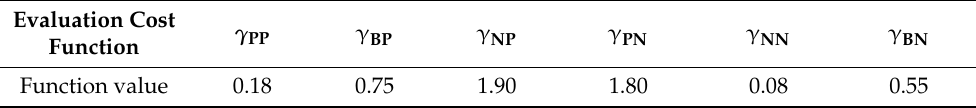
Table 2. Evaluation cost